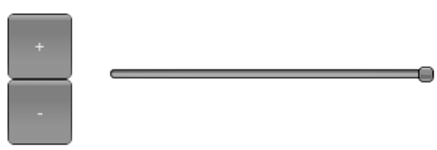
Figure 3. Input controls and panel efficiency control